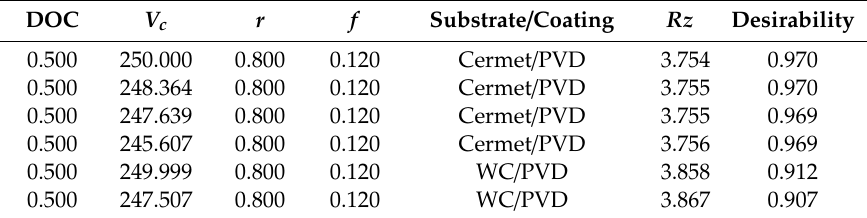
Table 11. Solutions for the Rz response